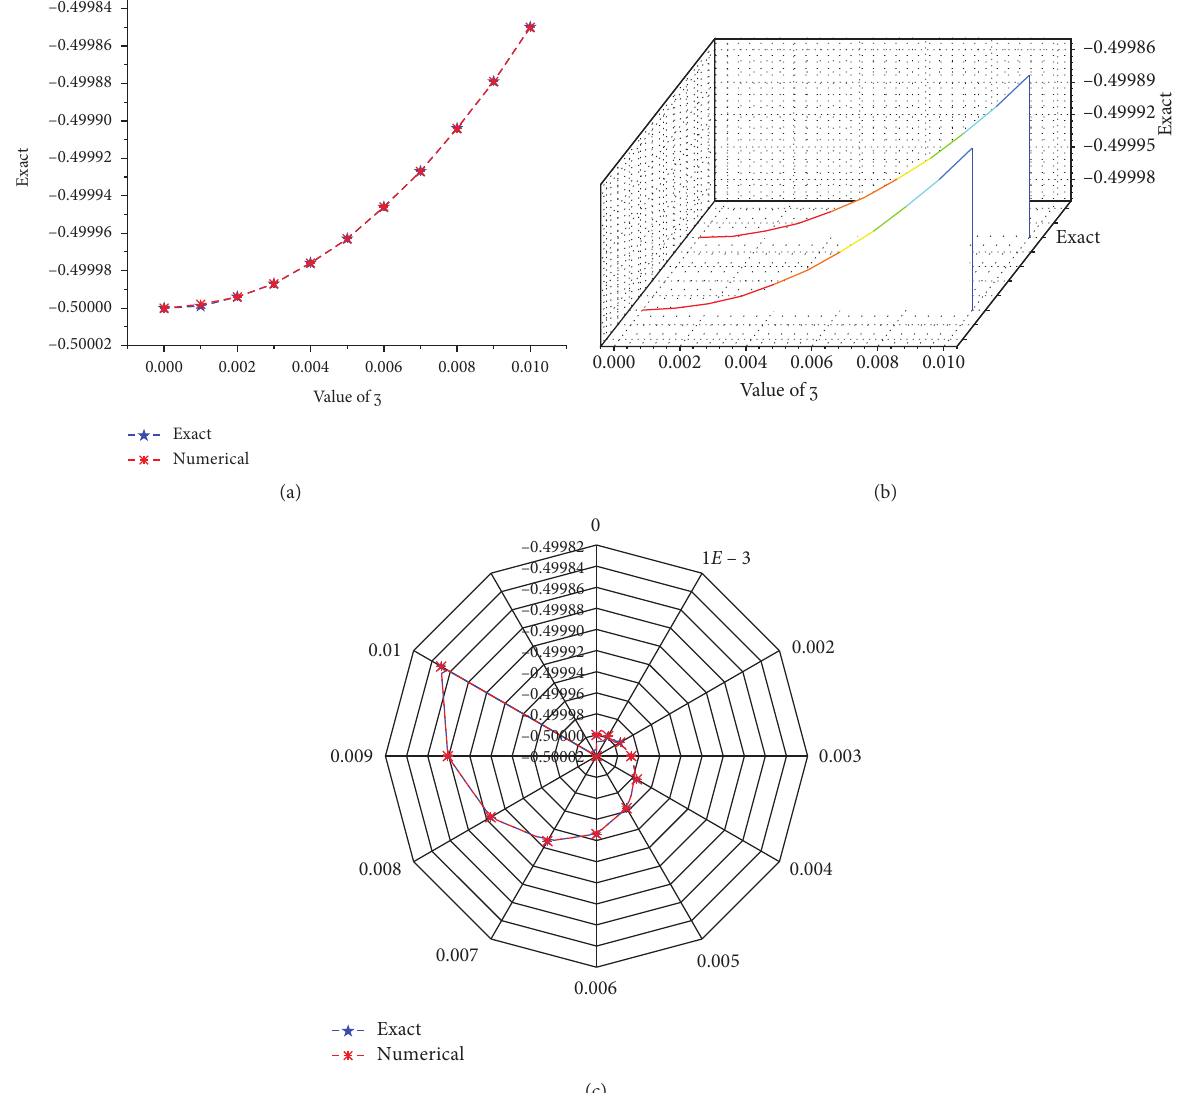
Figure 6: Exact and numerical solutions of equation (10) according to the obtained analytical solution via the sech-tanh expansion method.